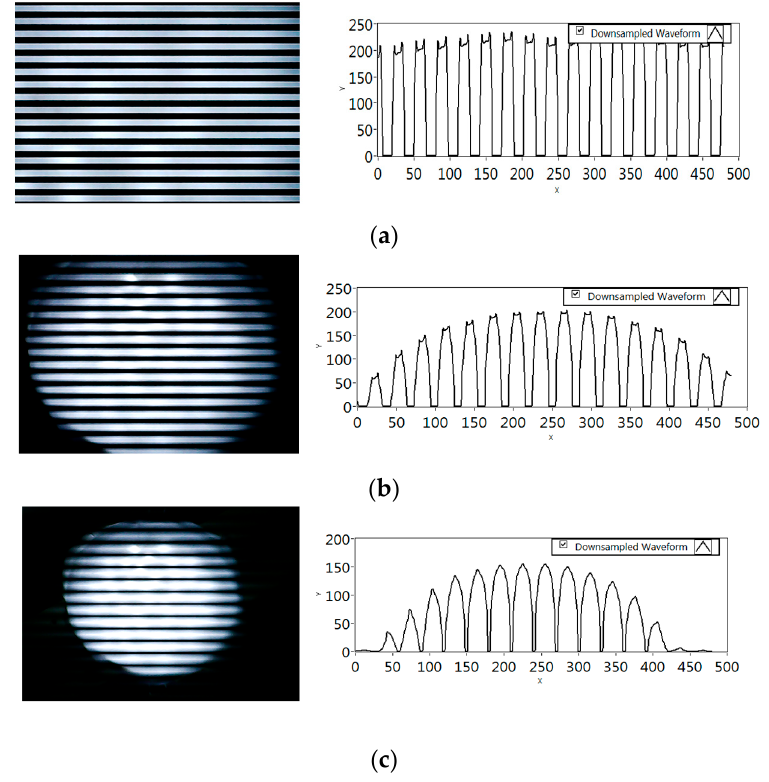
Figure 2. A PWM banding experiment. The size of the image of the circle LED (180 mm diameter) is decreased meaning that the amount of recoverable data is reduced when the distance is increased from ( a ) 20 cm ; ( b ) 40 cm; ( c ) 60 cm.